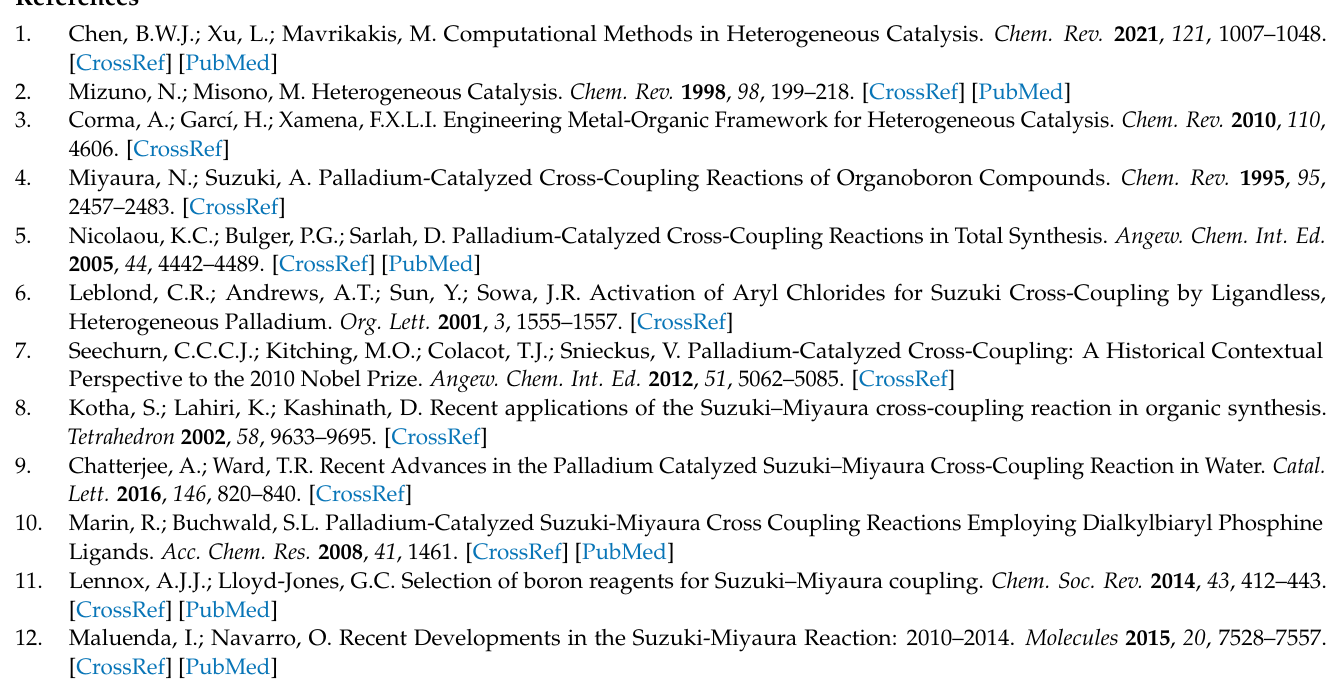
Catalyst 2; Figure S2: Solid-state 13 C CP/MAS NMR spectra of Catalyst 3 (cid:48) , Figure S3: Solid-state 13